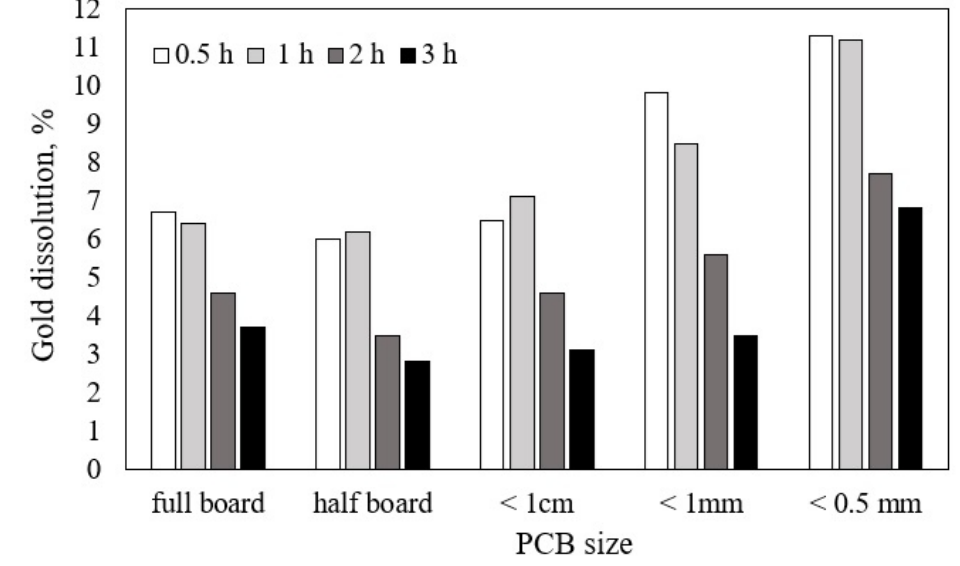
Figure 2. Leaching of PCB as a function of size and leach time.